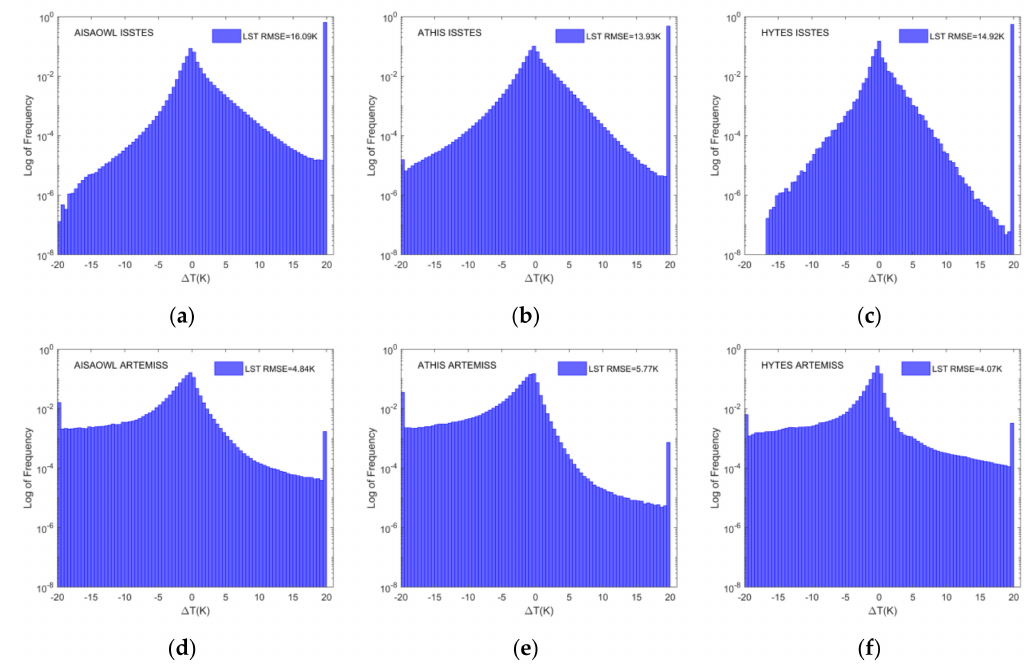
Figure 6. The overall LST error histogram. The X axis is the temperature error, the Y axis is the logarithm of frequency distribution of all retrieval LST errors with RMSE. ( a – c ) LST error histograms of AISAOWL (100 nm), ATHIS (50 nm) and HYTES (35 nm) inversed by ISSTES respectively; ( d – f ) LST error histograms of AISAOWL (100 nm), ATHIS (50 nm) and HYTES (35 nm) inversed by ARTEMISS